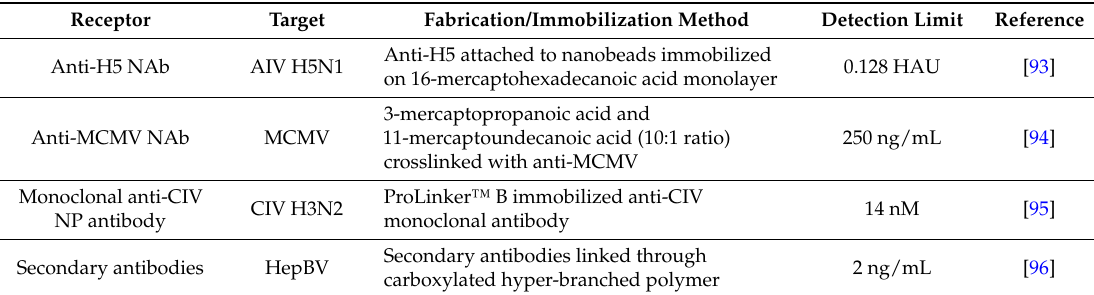
Table 2. The selected examples of the natural antibodies (NAb) as receptors for QCM-based viral